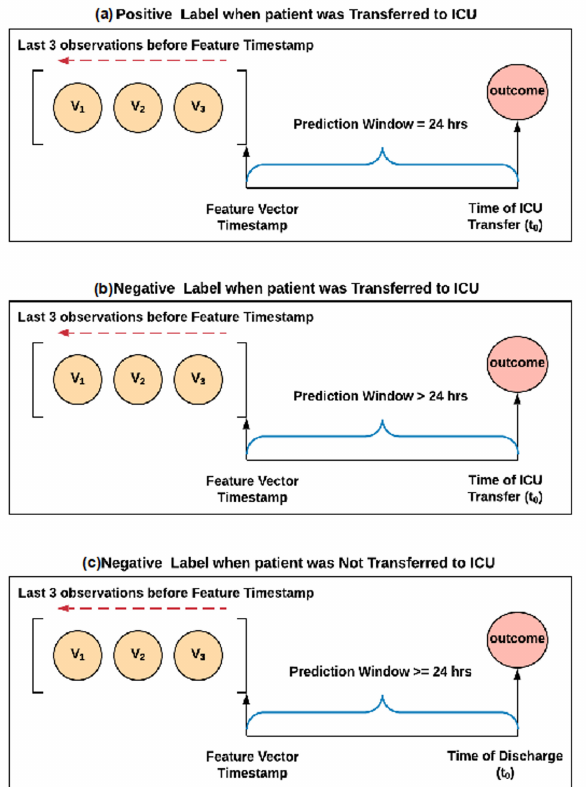
Figure 1. Feature vector labeling strategy. ( a ) Basis for positive labels; ( b ) and ( c ) basis for negative labels. V 1–3 : observations used for creating the feature vector; t 0 : time of ICU